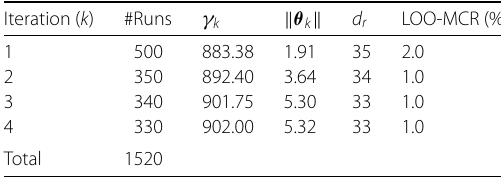
Table 5 Memory cell: ISMC exploration phase Iteration ( k ) #Runs γ k (cid:21) θ k (cid:21) 1 1000 878.72 1.30 2 1000 884.99 2.36 3 1000 890.40 3.38 4 1000 896.01 4.14 5 1000 901.10 5.26 6 1000 902.00 5.31 Total 6000